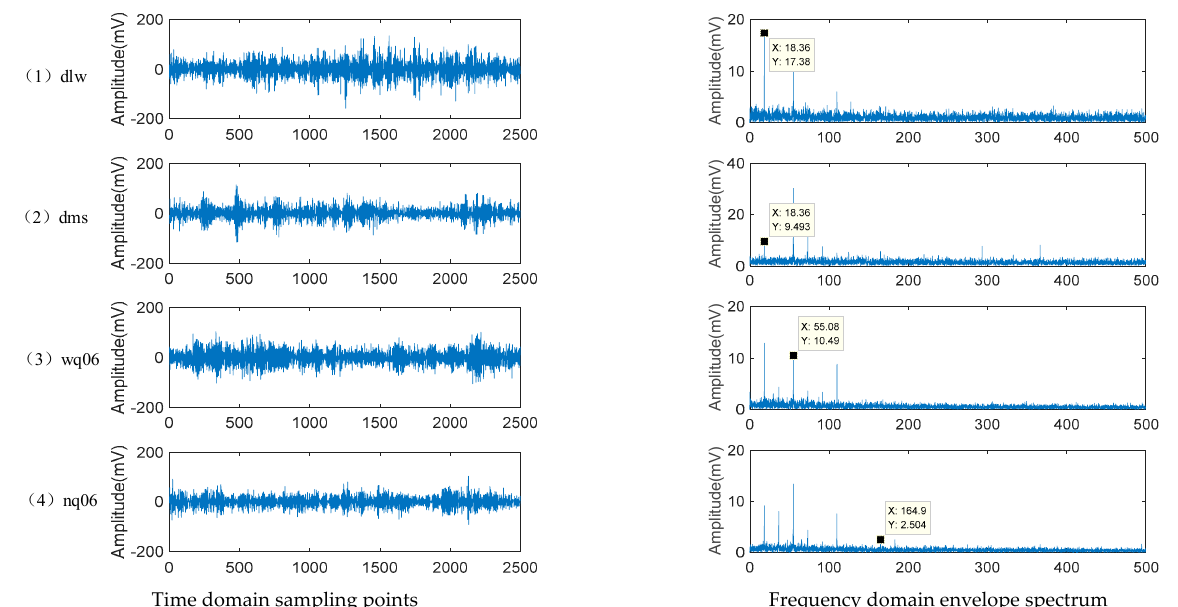
Figure 9. Time domain and envelope spectrum graphs with signals of different health conditions.